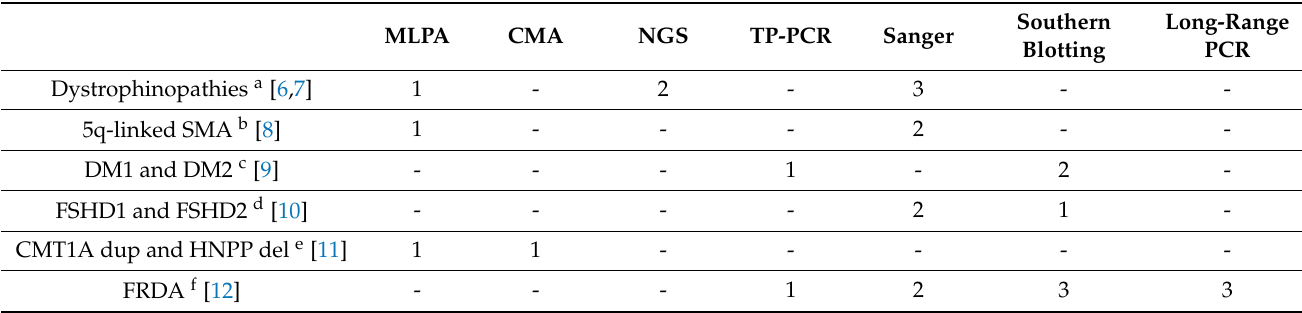
Table 1. Neuromuscular diseases in which genetic testing of a single-gene approach is